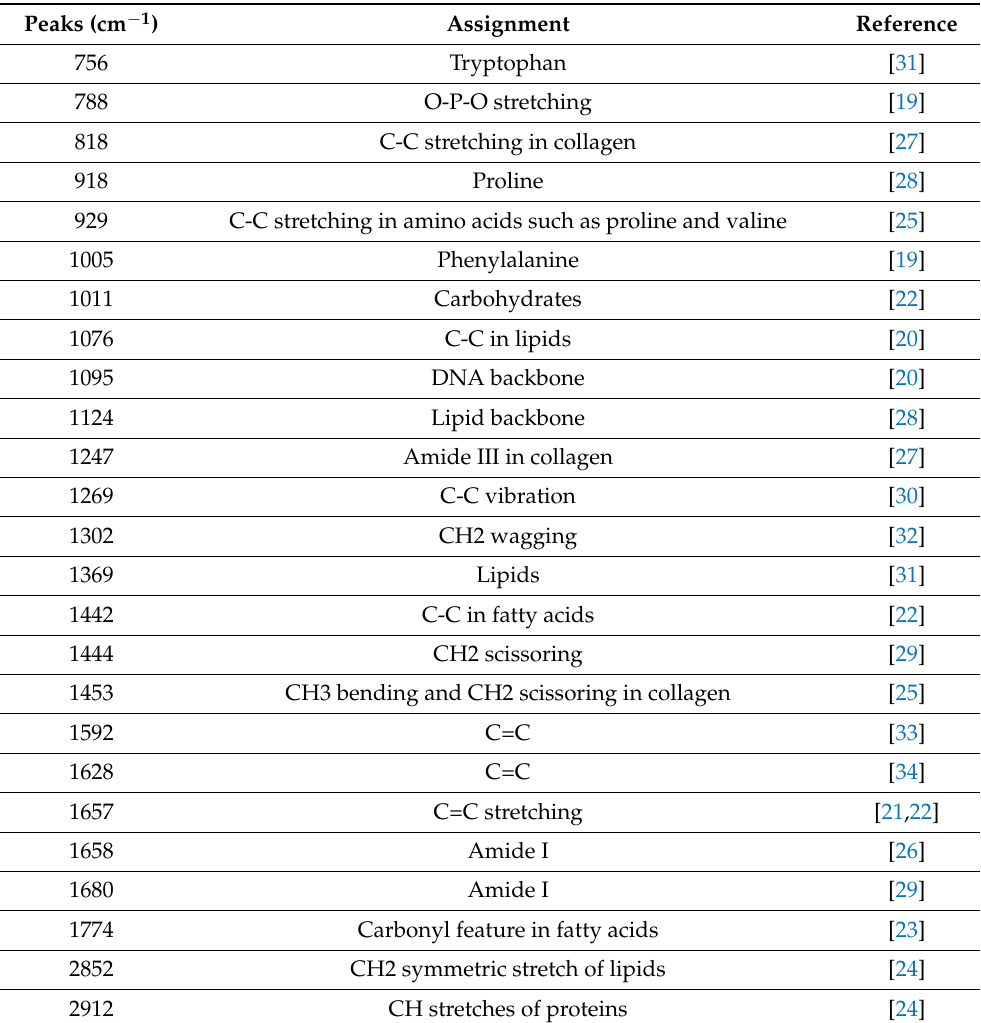
Table 3. Identified Raman peaks [cm − 1 ] and their molecular